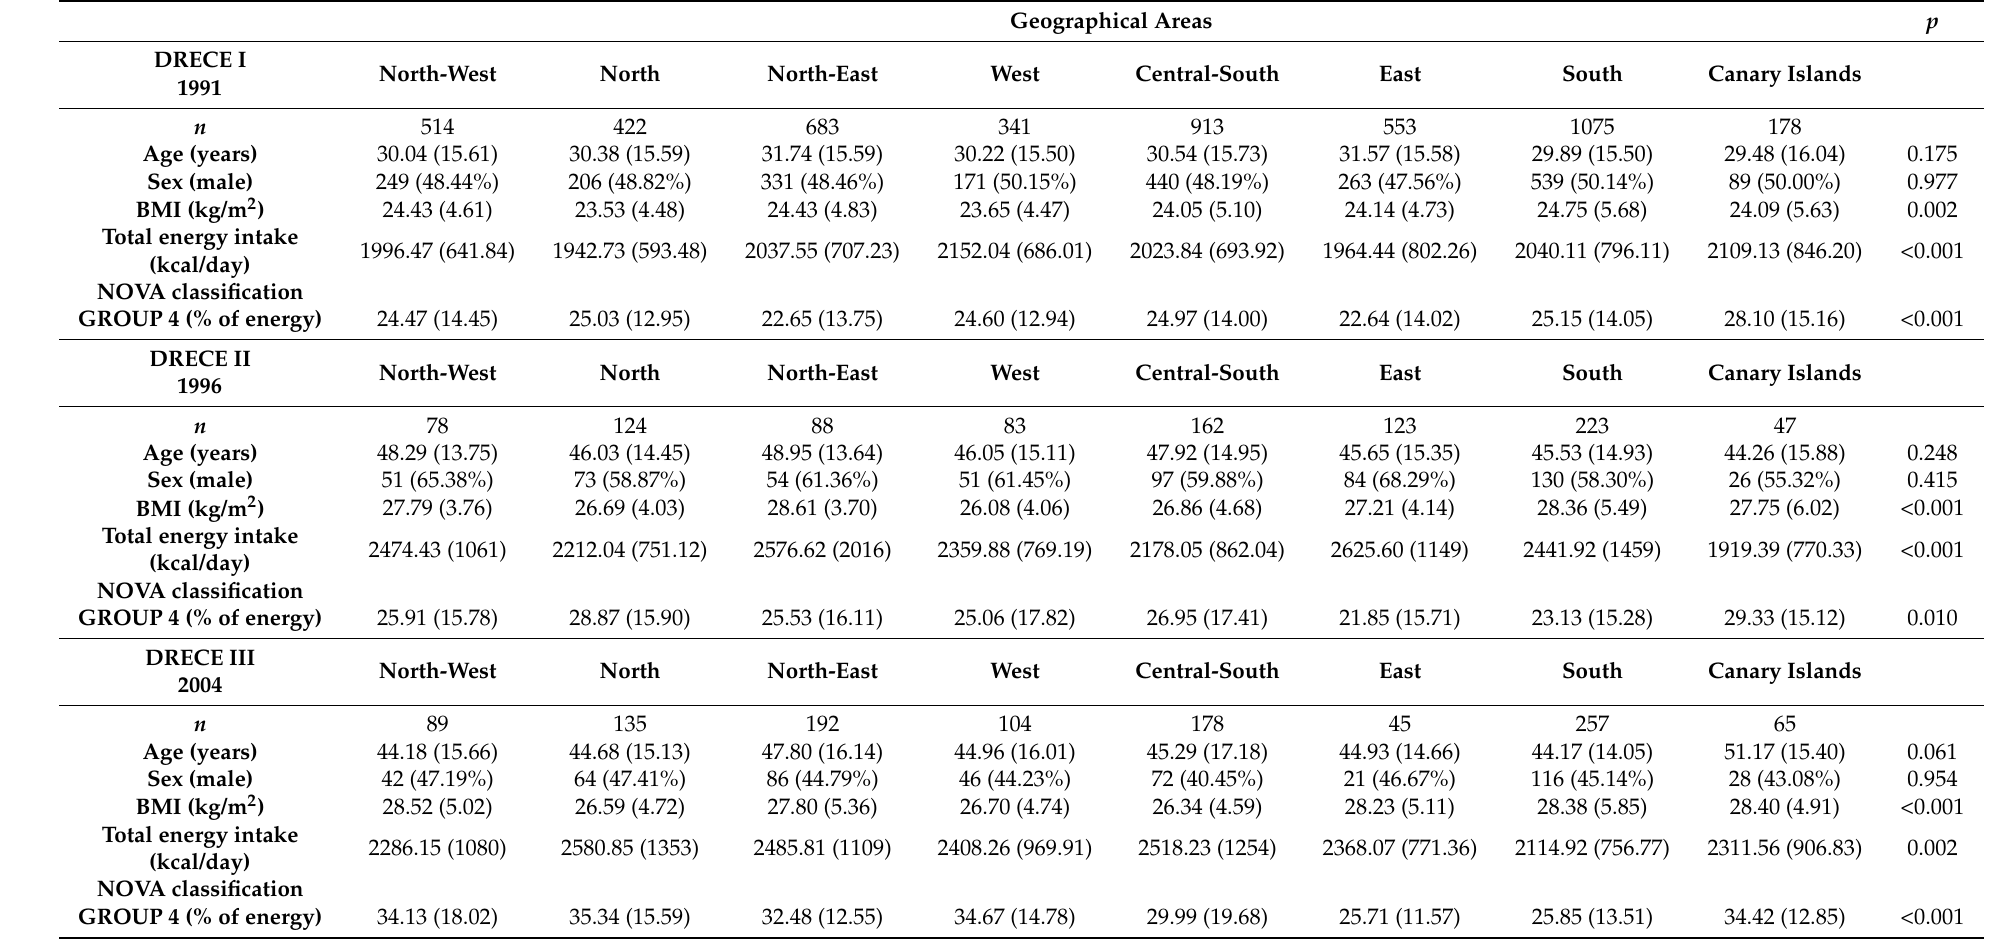
Table 3. Ultra-processed food (NOVA 4) intake and demographic characteristic by geographical